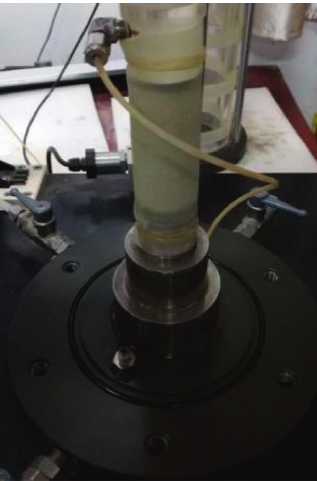
Figure 4: Calcareous sand